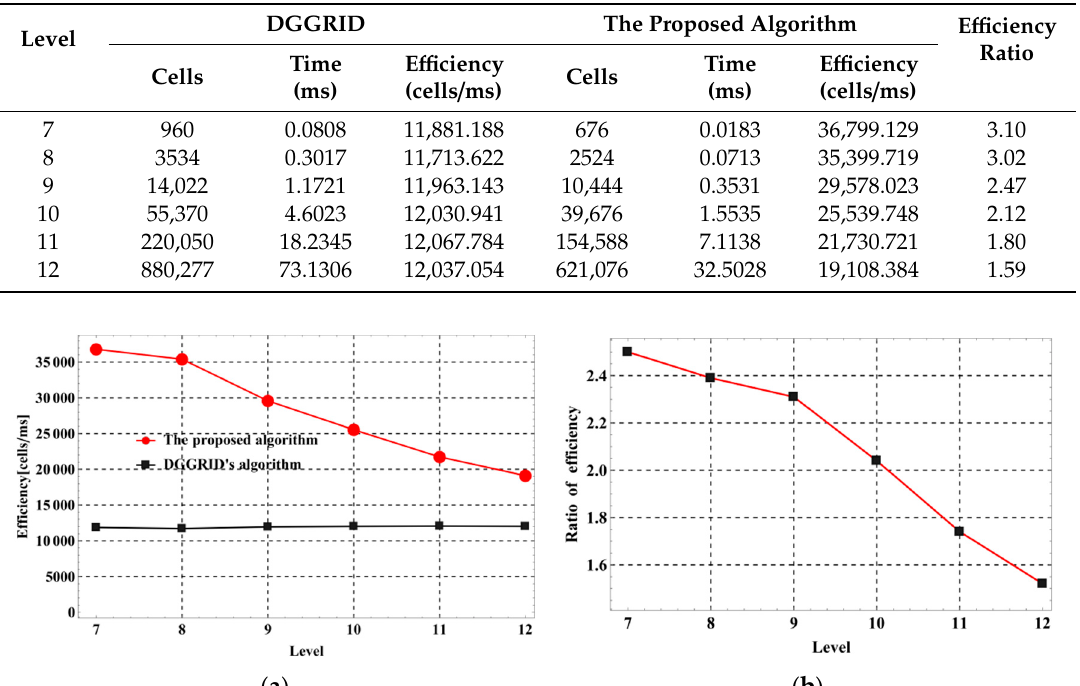
Table 1. Results of the single-level indexing comparison experiment.